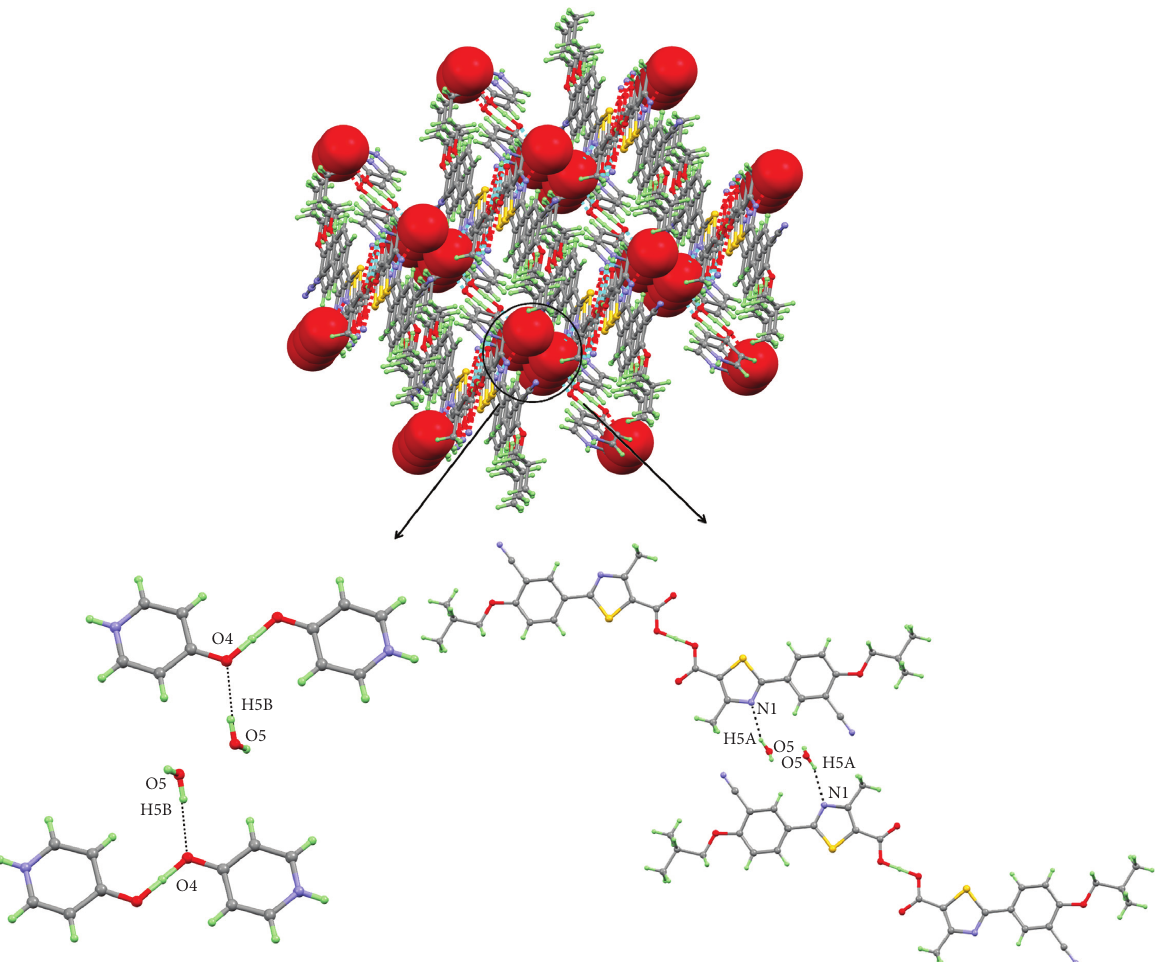
Figure 7: The visualization of water molecules in the crystal structure channel of FEB-4HP-H